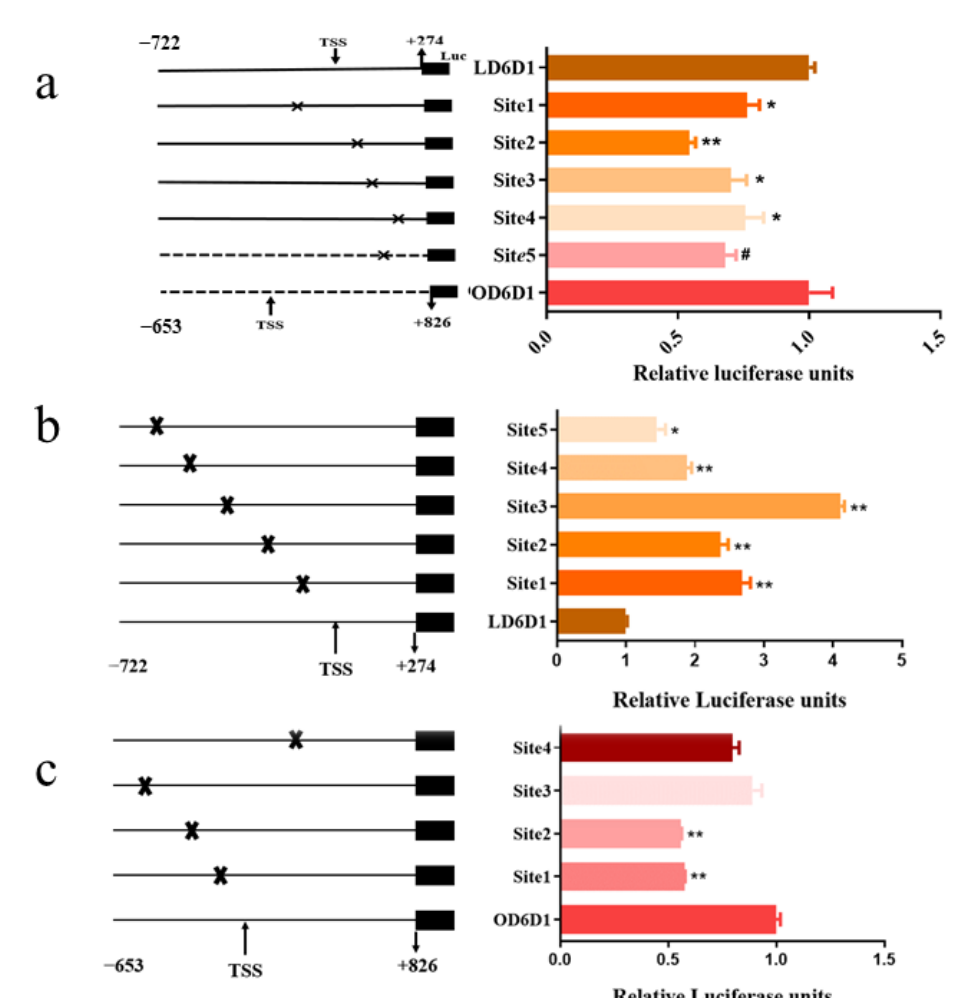
Figure 8. Site-directed mutation of C/EBP α and GATA3 binding sites. The effect of C/EBP α site- directed mutation on large yellow croaker and rainbow trout fads2 promoter activity ( a ). The effect of GATA3 site-directed mutation on large yellow croaker ( b ) and rainbow trout ( c ) fads2 promoter activity. Each constructed site-directed mutant was co-transfected with C/EBP α or GATA3 over-expression plasmids and phRL-CMV, and the promoter activity normalized to corresponding non-mutated promoter, LD6D1 and OD6D1. Values are presented as mean ± SEM ( n = 3). TSS: transcription start site. The “*” and “#” means a significant difference ( p < 0.05) and “**” means a highly significant difference ( p < 0.01).